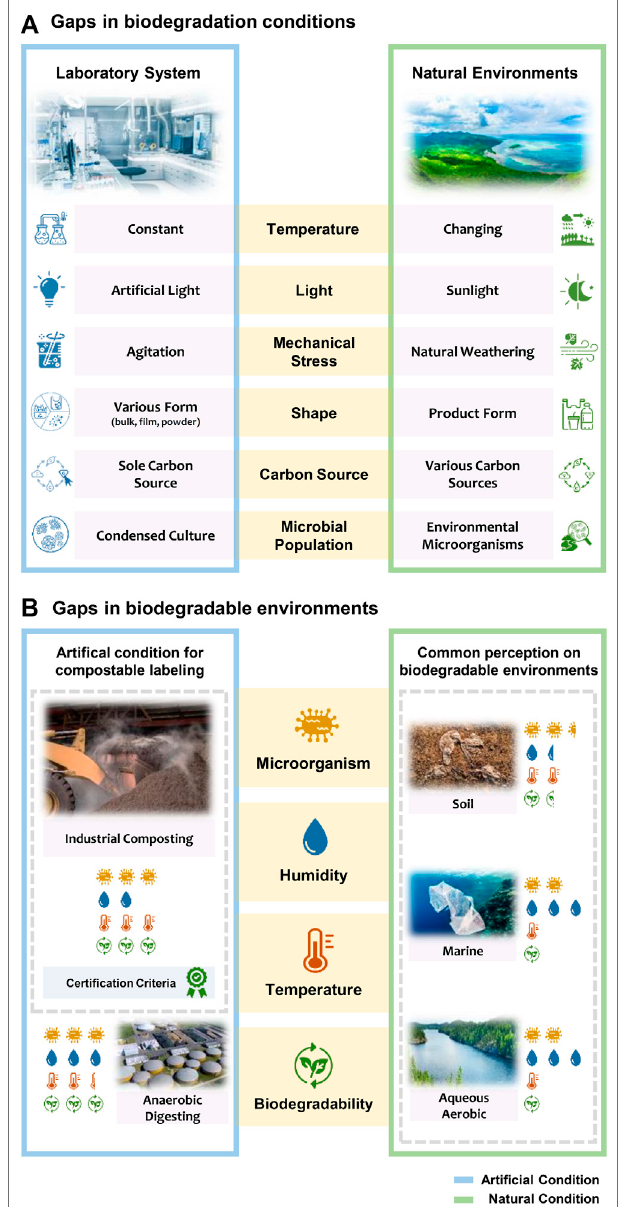
FIGURE 2 | (A) Disparity in biodegradation conditions in the laboratory and in the natural environments. (B) The discrepancy between public perception and the actual biodegradability of labeled products. An industrial composting test is commonly applied for the certi fi cation, but the conditions in industrial composting facilities hardly exist in natural